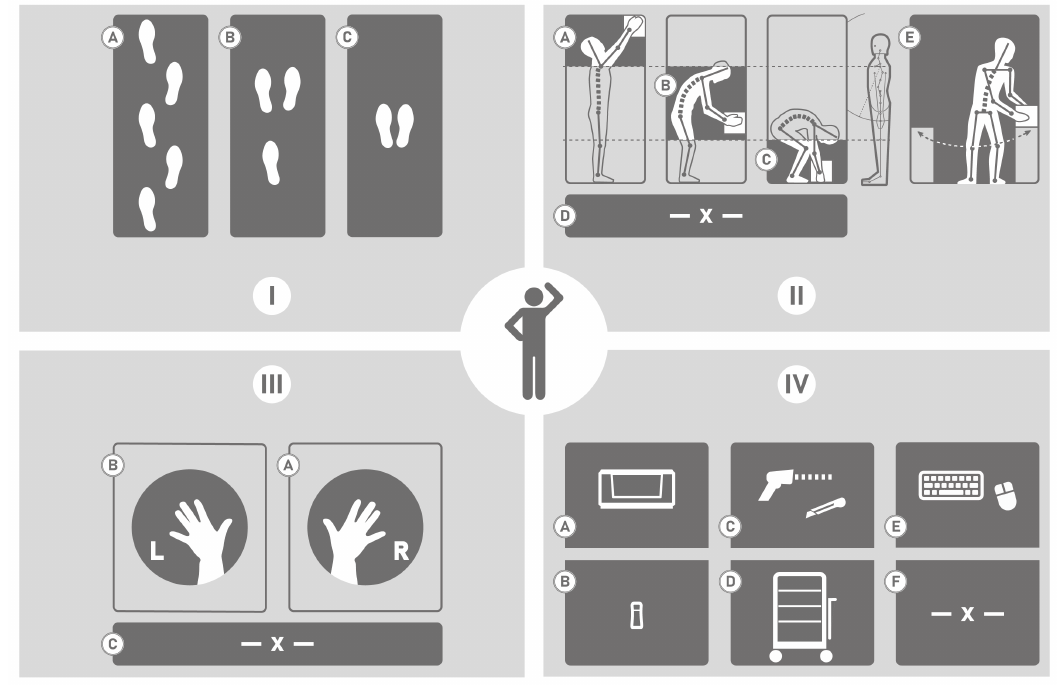
Figure 11. Semantic